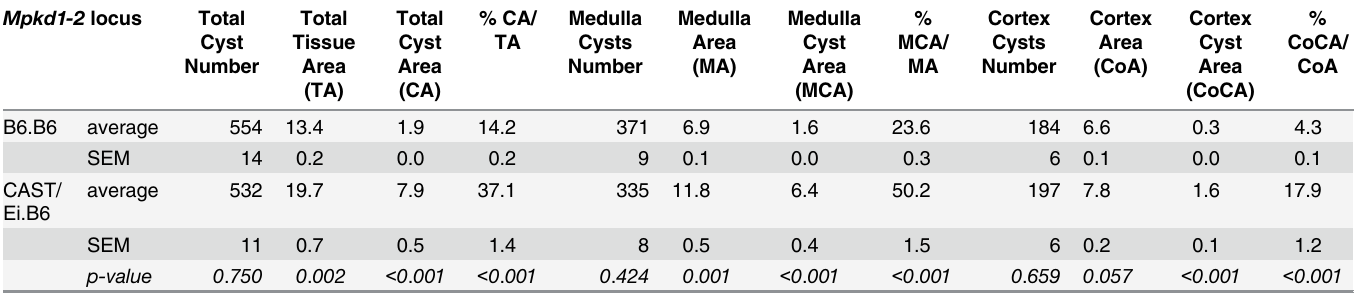
Table 1. Renal cystic indices of mice with one CAST/Ei-derived and one C57BL/6J-derived Mpkd1-2 locus (CAST/Ei.B6) vs. two C57BL/6J-derived Mpkd1-2 loci (B6.B6) Mpkd1-2